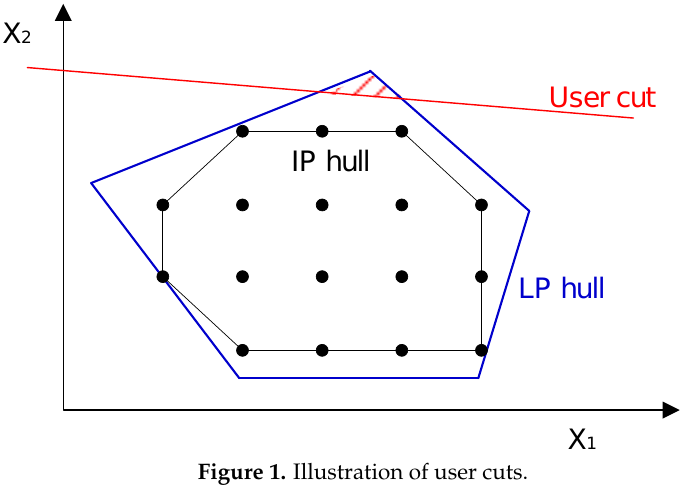
Figure 1. Illustration of user